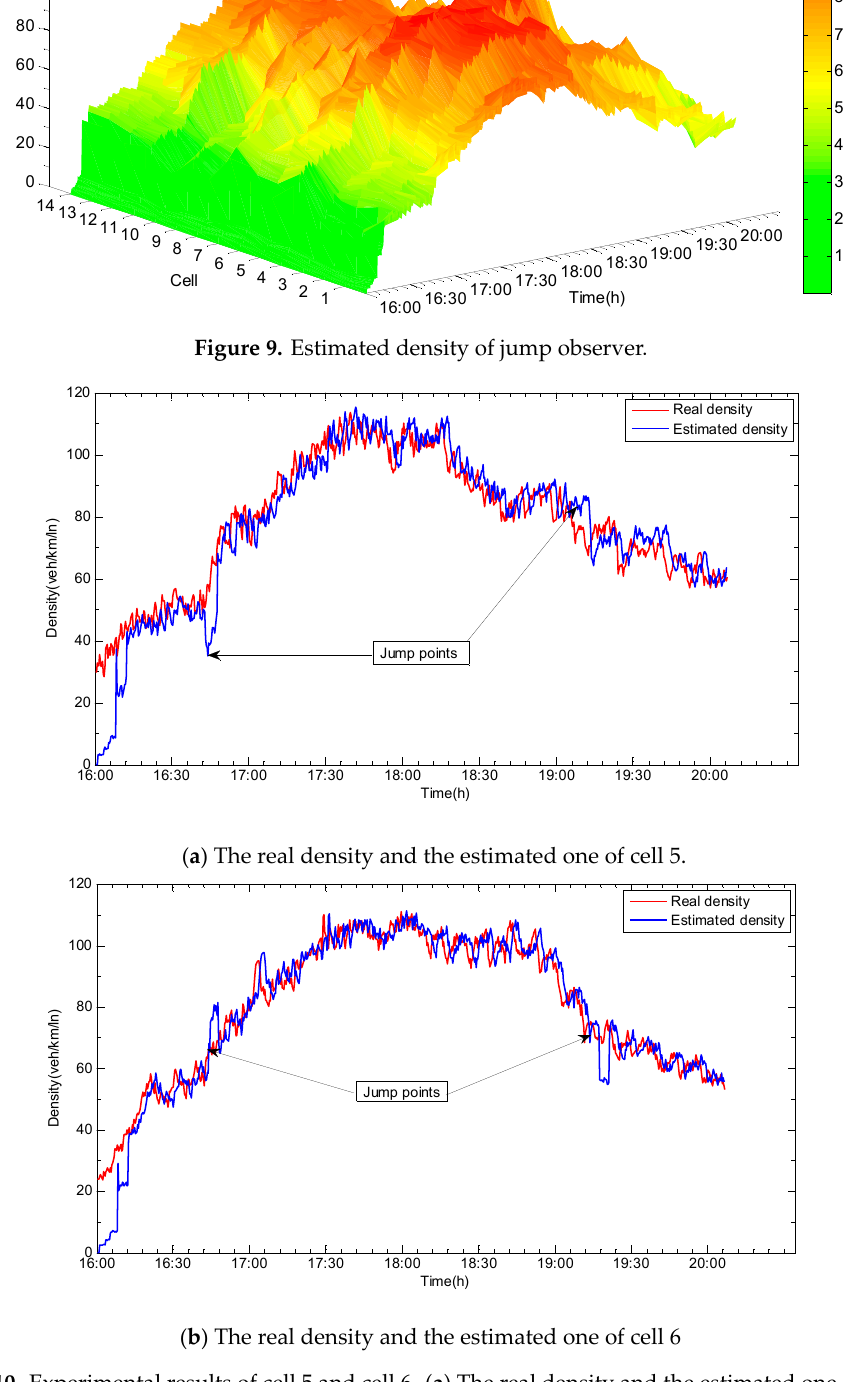
Figure 8. Error curve of state jump observer.